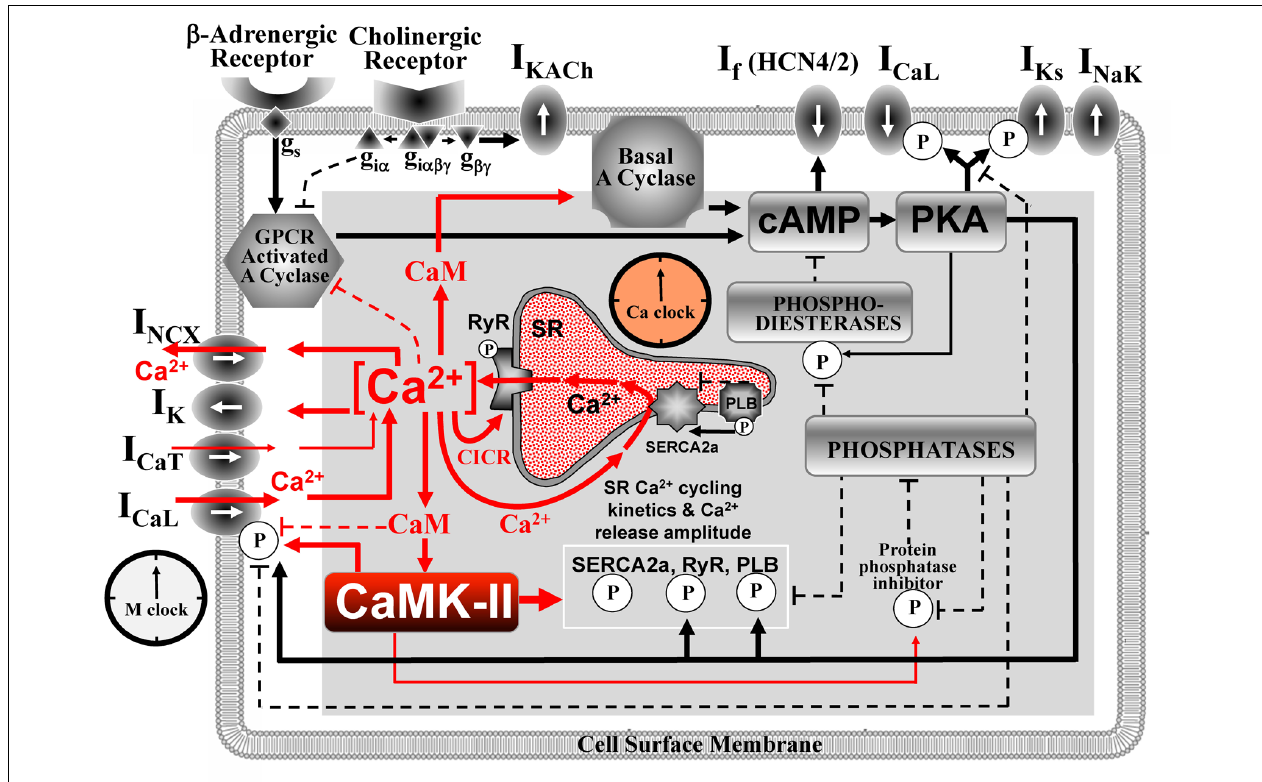
function of both clocks activities. The system is balanced: signals accelerating action potential (AP) firing are balanced by signals suppressing AP firing. This balance determines a given steady-state level of net Ca 2 + , cAMP, and protein phosphorylation via PKA, and CaMKII. G protein-coupled receptors (top left corner) within the cell membrane modulate both the Ca 2 + -clock and M-clock function via the same crucial signaling nodes of the system. Modified from Lakatta etal.